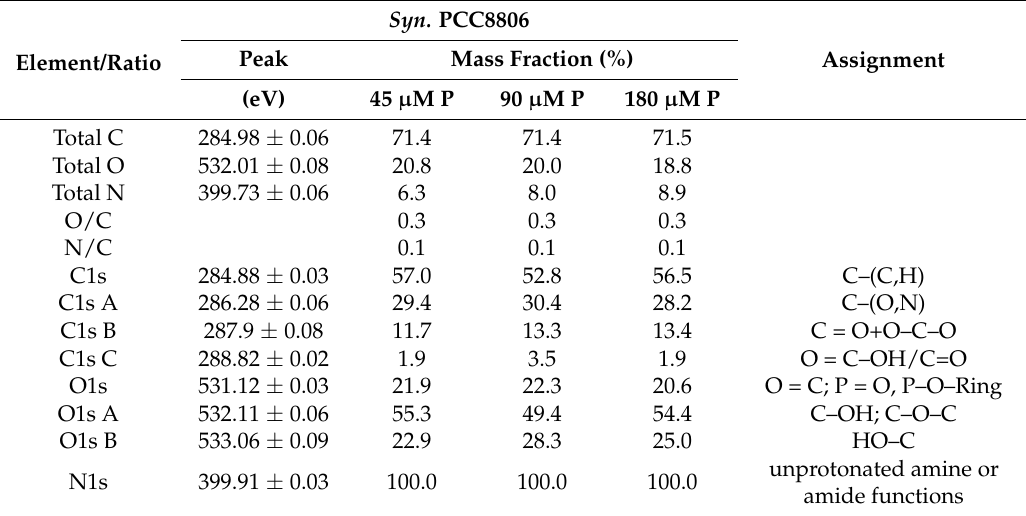
Table 2. Energy (eV) of the low and high-resolution X-ray photoelectron spectroscopy (XPS) spectral bands, mass fractions (%), and band